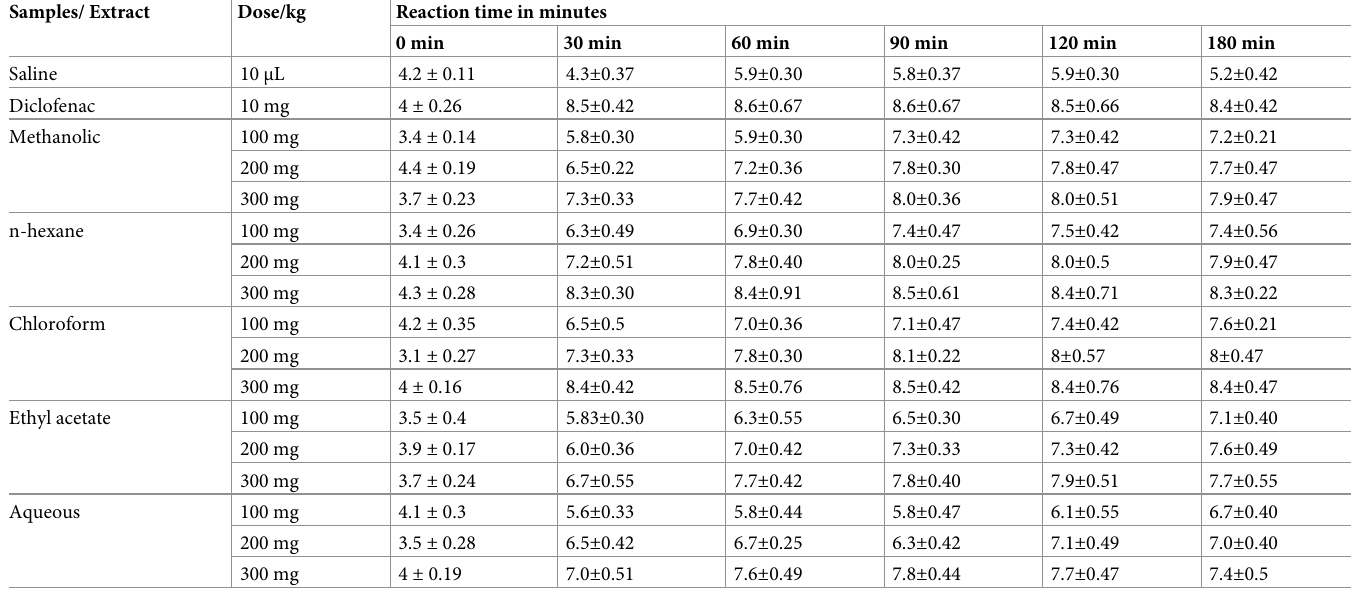
Table 5. Effect of Iris albicans crude and its corresponding fractions on hot-plate test in mice. Samples/ Extract